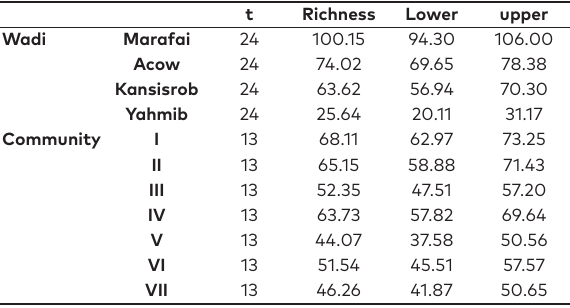
Table 4. Sample based rarified richness for the four stud- ied wadis and the seven studied communities at sample size equal 24 relevés for wadis and 13 for